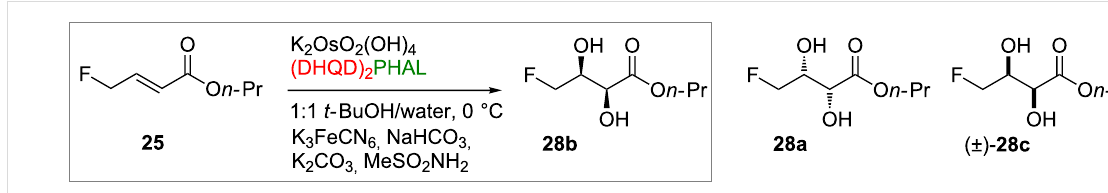
Scheme 5: Typical AD procedure; see Table 1 for outcomes.